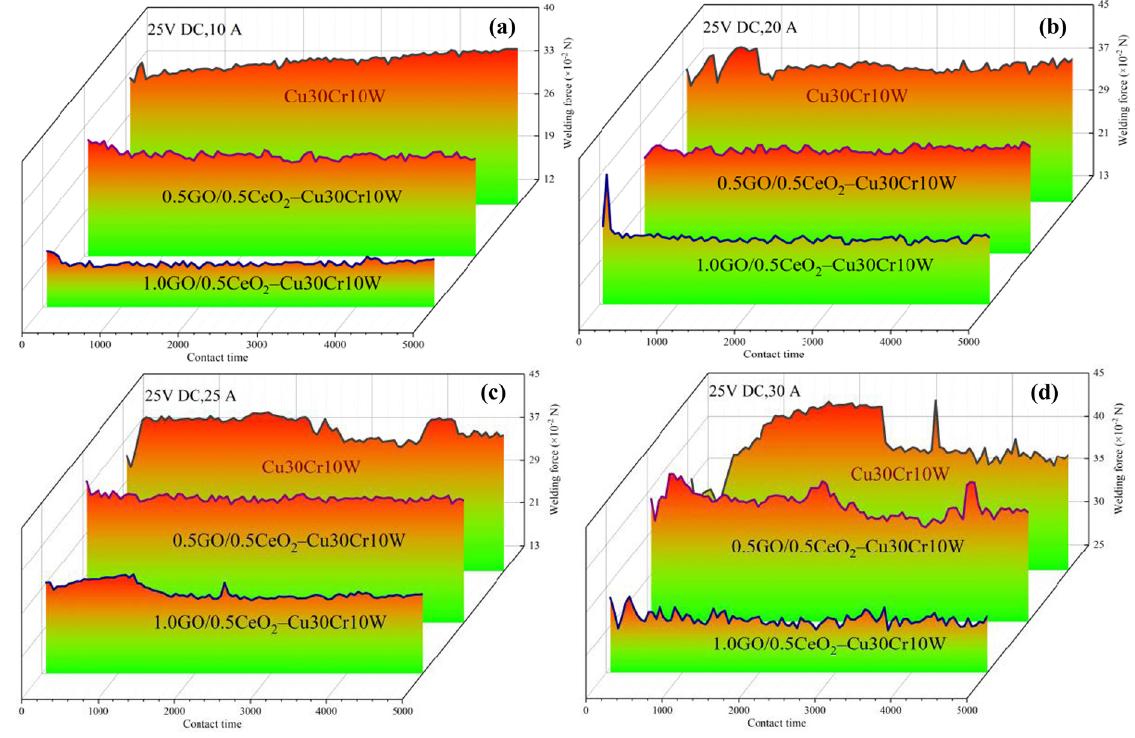
Figure 10: Welding forces of di ff erent composites at ( a ) 25 V DC, 10 A, ( b ) 25 V DC, 20 A, ( c ) 25 V DC, 25 A, and ( d ) 25 V DC, 30